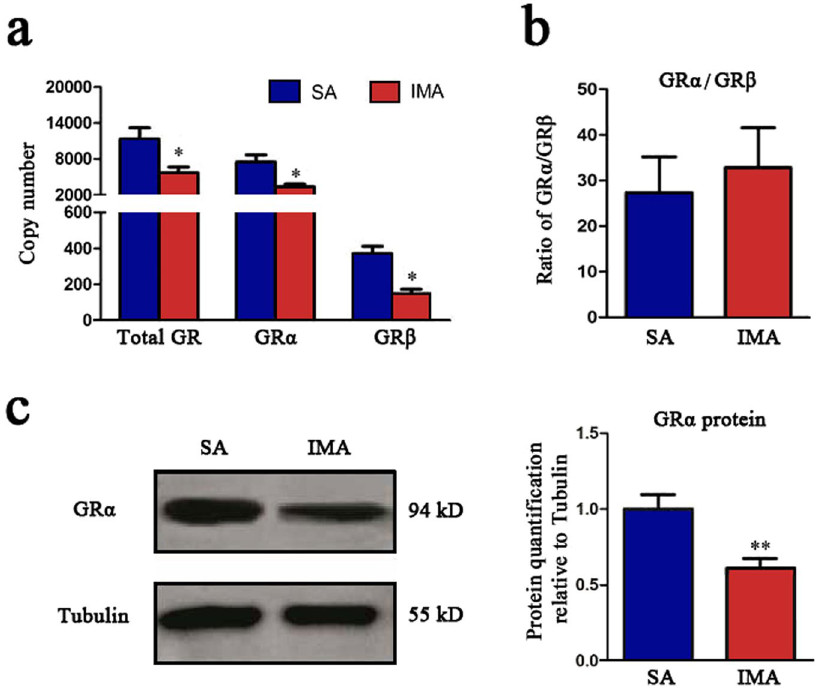
Figure 2. GR levels in IMA were lower than SA. Backfat and longissimus dorsi muscles were from 12 Erhualian sows, then the adipose tissues were collected for RNA and protein isolation. ( a ) Copy numbers of total GR, GR α , GR β mRNA in SA and IMA tissues were detected by RT-qPCR. ( b ) The ratio of GR α /GR β was displayed according to the result obtained in ( a ). Data are shown as the mean ± SEM, n = 12 per group, * P < 0.05. ( c ) Expression of GR α protein in SA and IMA tissues was detected by Western blot (left), and the relative protein expression level was displayed as column charts (right). n = 3 per group, ** P <